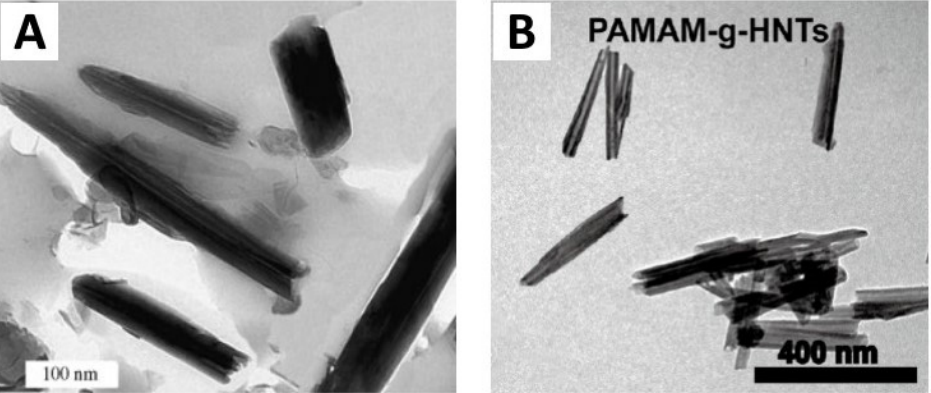
Figure 8. ( A ) HNTs after CaCO 3 precipitation. Reproduced with permission from [133]. Copyright 2005 John Wiley and Sons, ( B ) polyamidoamine (PAMAM) grafted HNTs. Reprinted with permission from Ref. [102]. Copyright 2018 American Chemical Society.